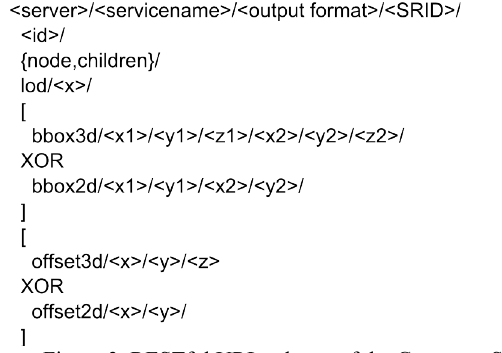
Figure 3. RESTful URL schema of the Geometry